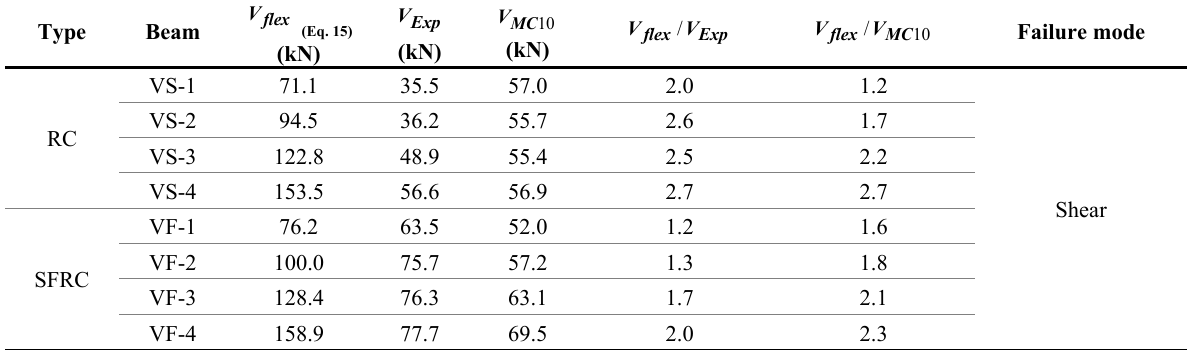
Table 5. Failure mode